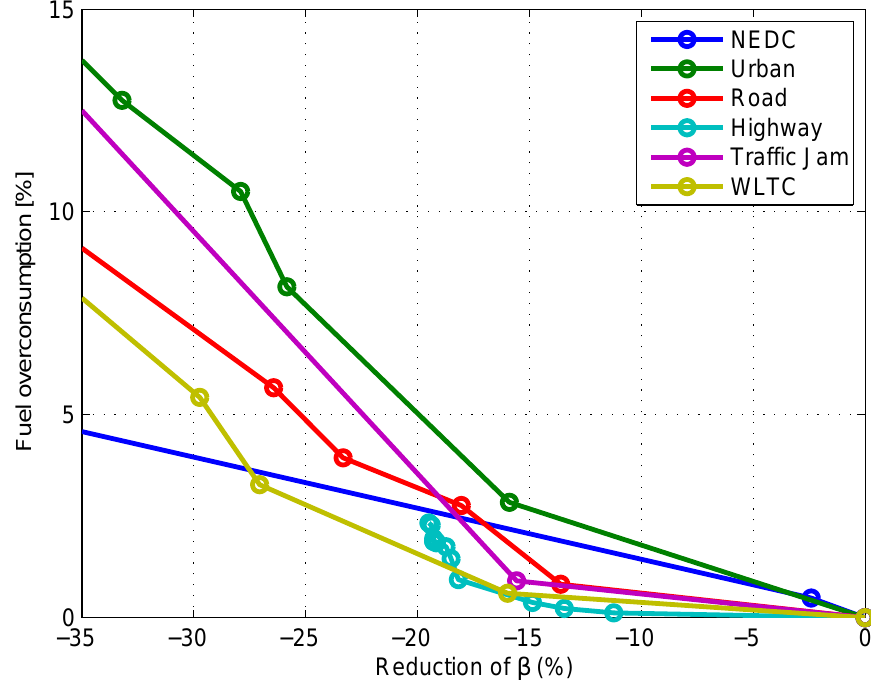
Figure 8. Trade-off curve of the fuel overconsumption versus discomfort Equation (20) = 0 normalized with κ comf